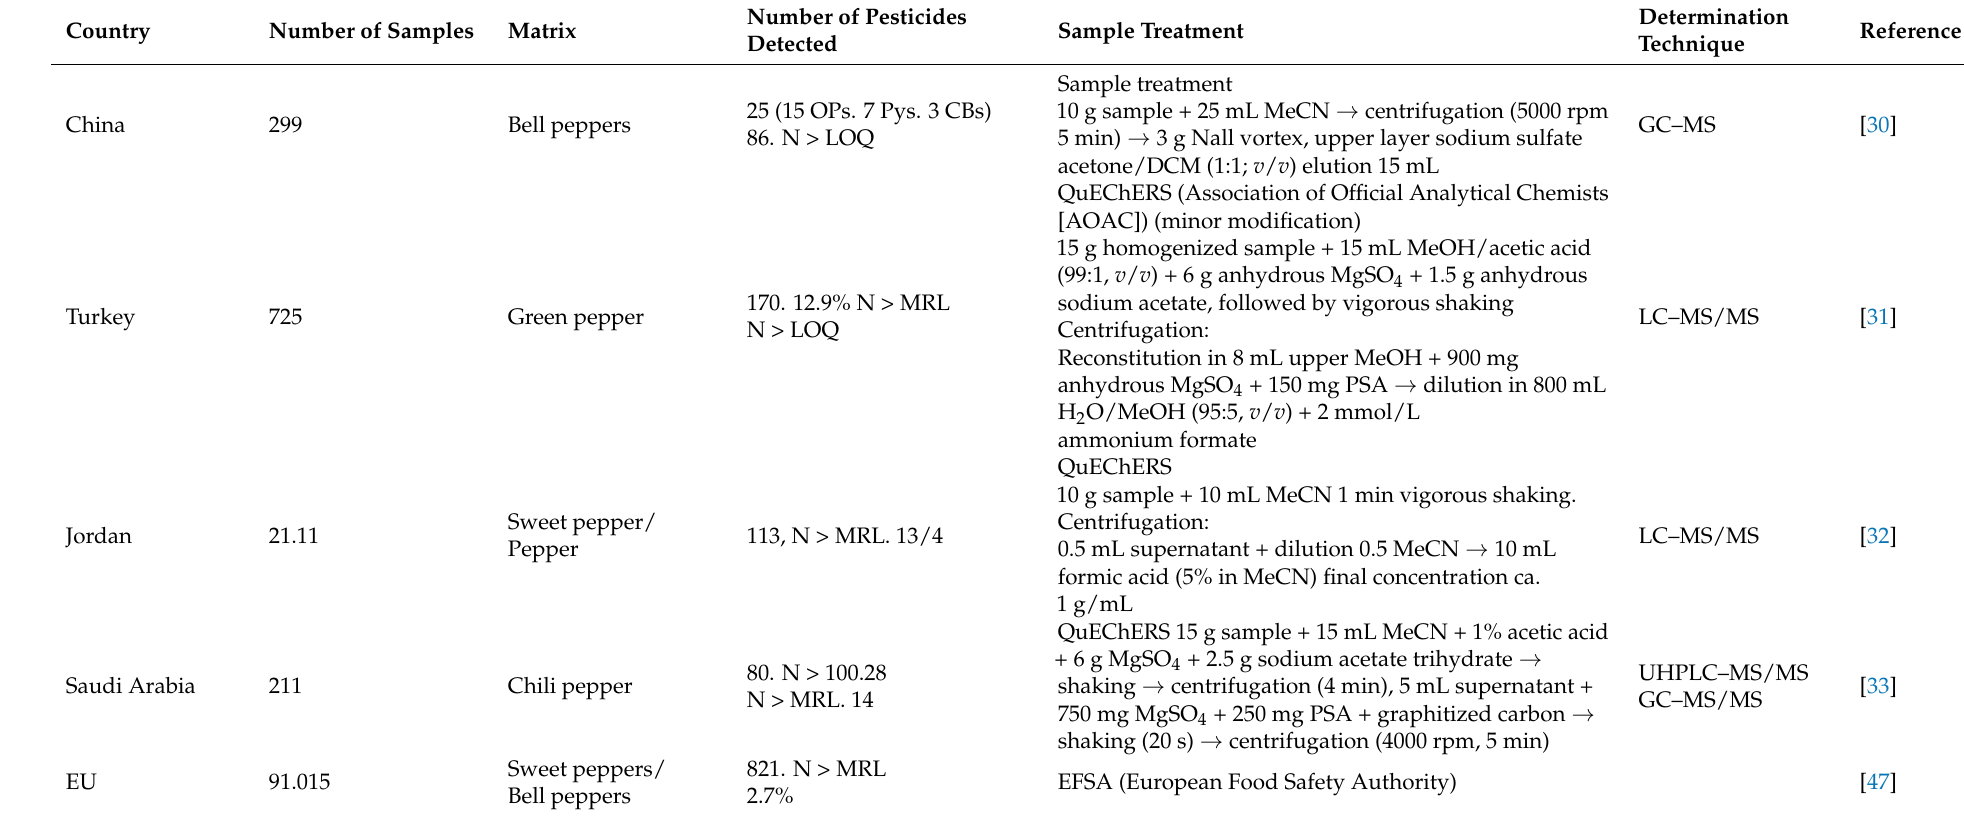
Table 2. Overview of international monitoring for the analysis of pesticides in